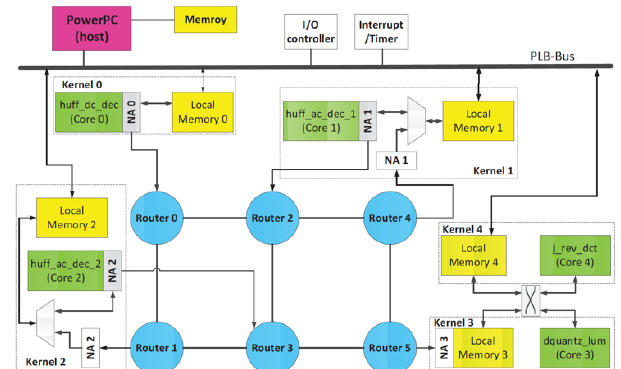
Figure 5. The architecture for jpeg application in the embedded platform